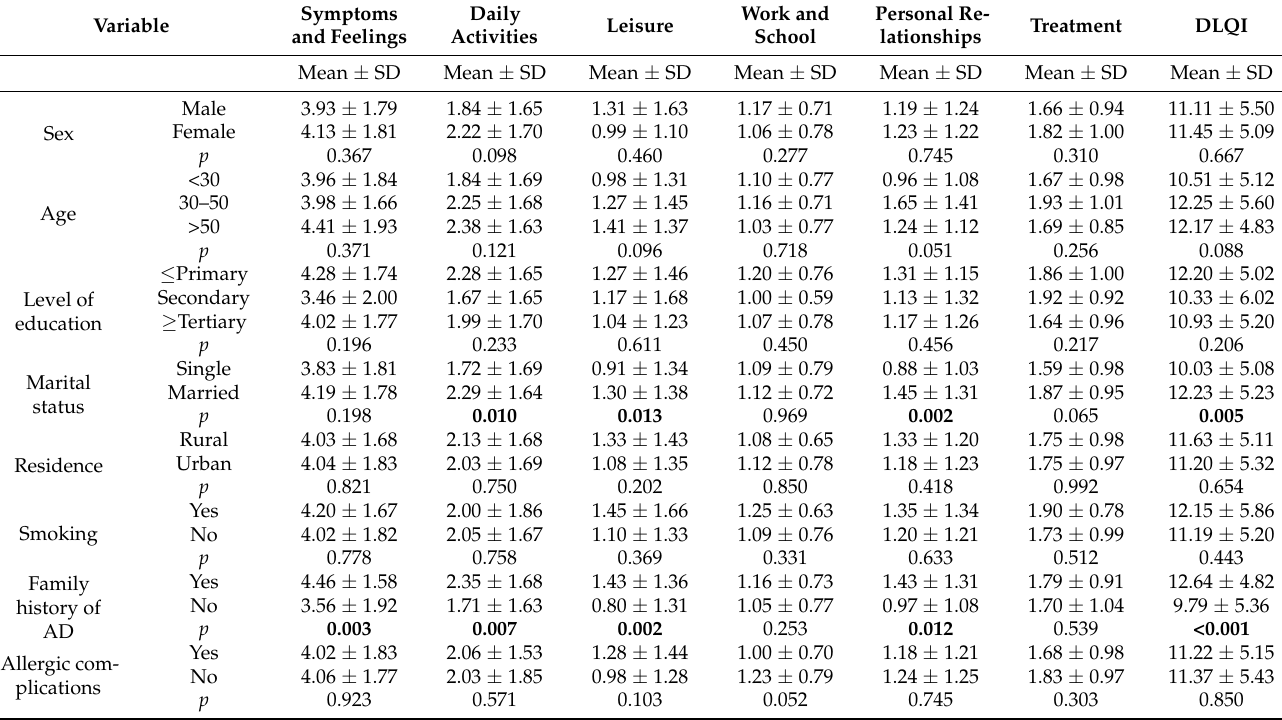
Table 4. Bivariate association between the patients’ demographic characteristics and domain-specific and overall DLQI scores.